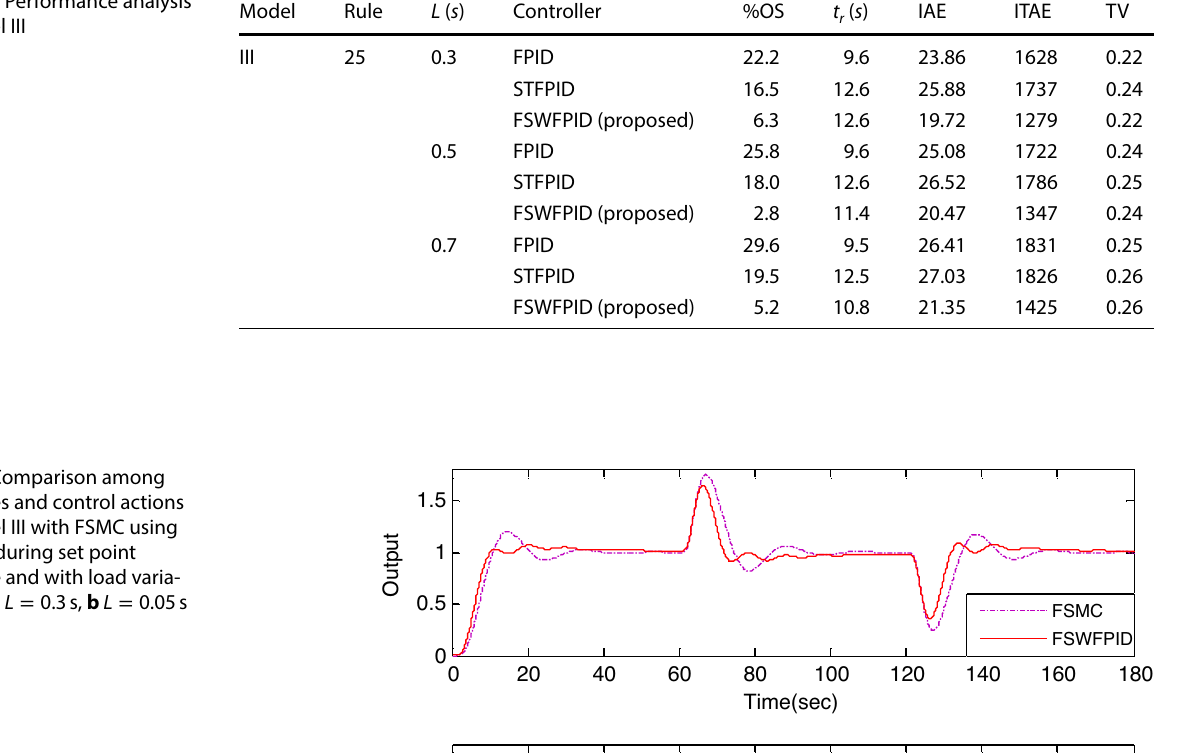
Table 10 Performance analysis for Model III